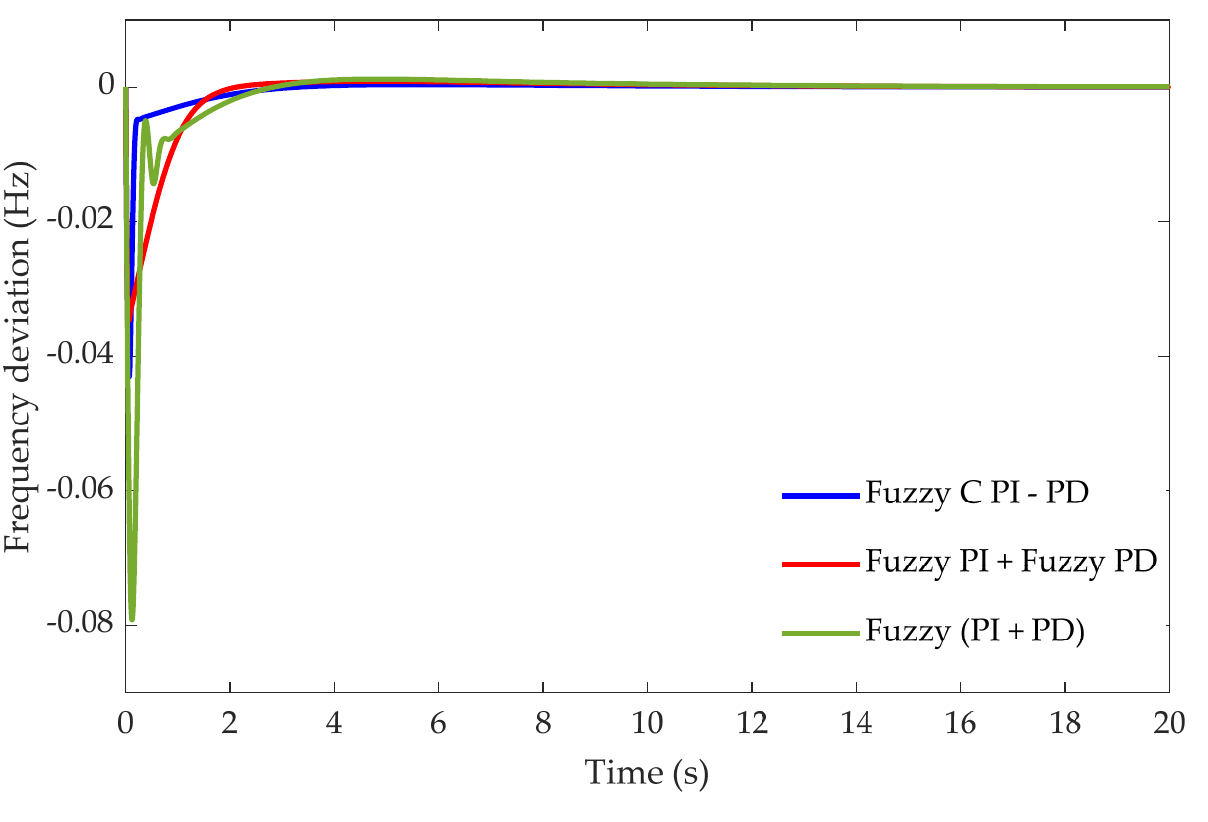
Figure 19. Frequency deviation in area one ( ∆ F 1 in Hz).